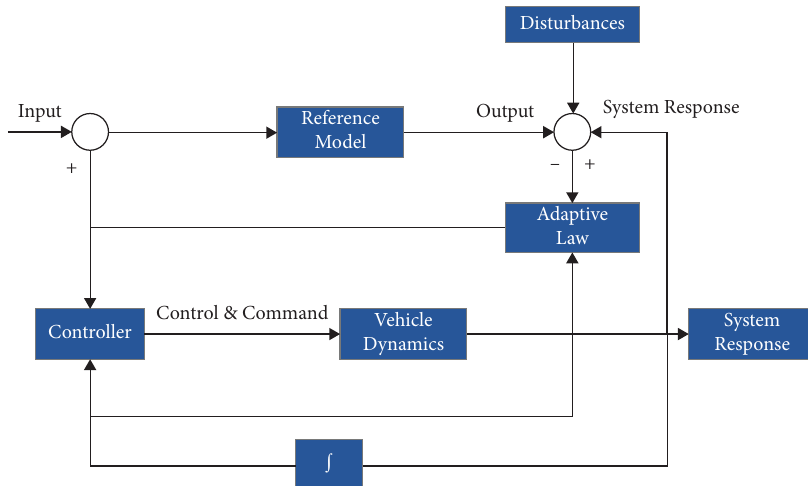
Figure 4: Control structure of the controller with integral feedback.